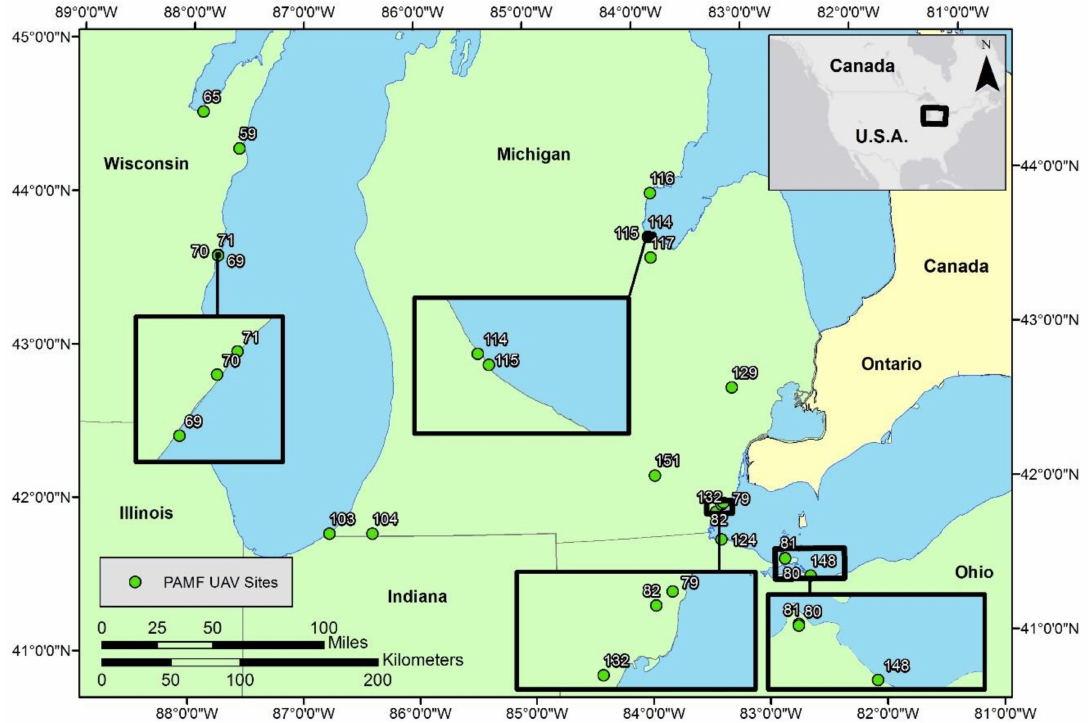
Figure 1. Locations of the 20 Phragmites Adaptive Management Program (PAMF) sites where UAV-collected imagery was used for Phragmites treatment site